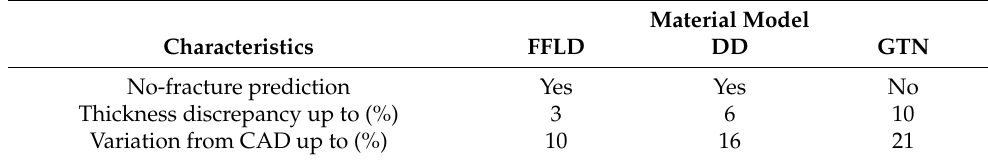
Table 4. Summary of